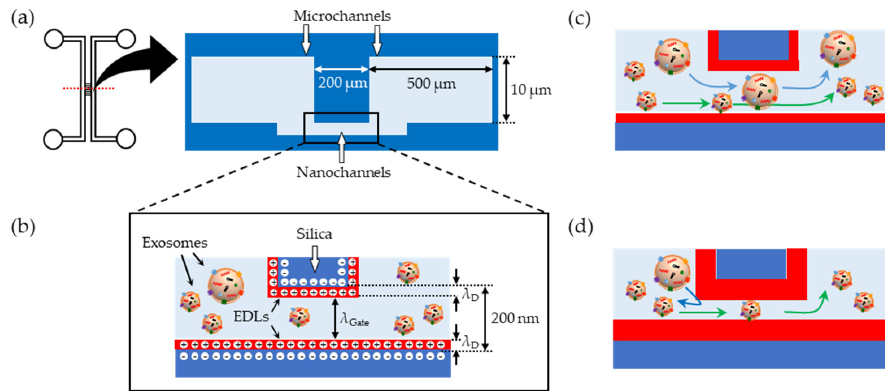
Figure 1. Schematic illustration of the proposed size sorting of exosomes. ( a ) Channel configuration and cross-sectional view of the developed micro-nanofluidic device. ( b ) Schematic of electric double layers (EDLs) formed on the inner surface of the nanochannels. ( c , d ) Schematic illustrations of the size sorting of exosomes by tuning the thicknesses of EDLs by employing background electrolytes at ( c ) high and ( d ) low concentrations. ( c ) high and ( d ) low